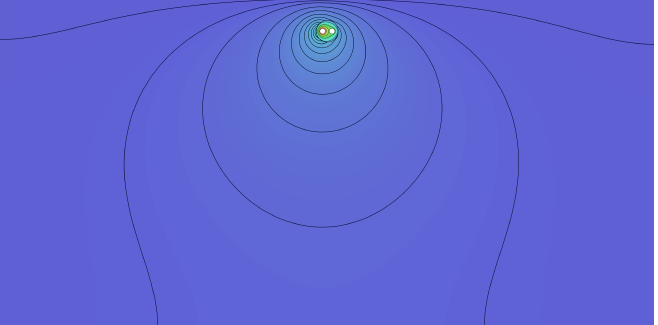
Figure 3. Isotherm contour plots for H = 6, W = 4, L = 1.75, T r = 0.5 and K =